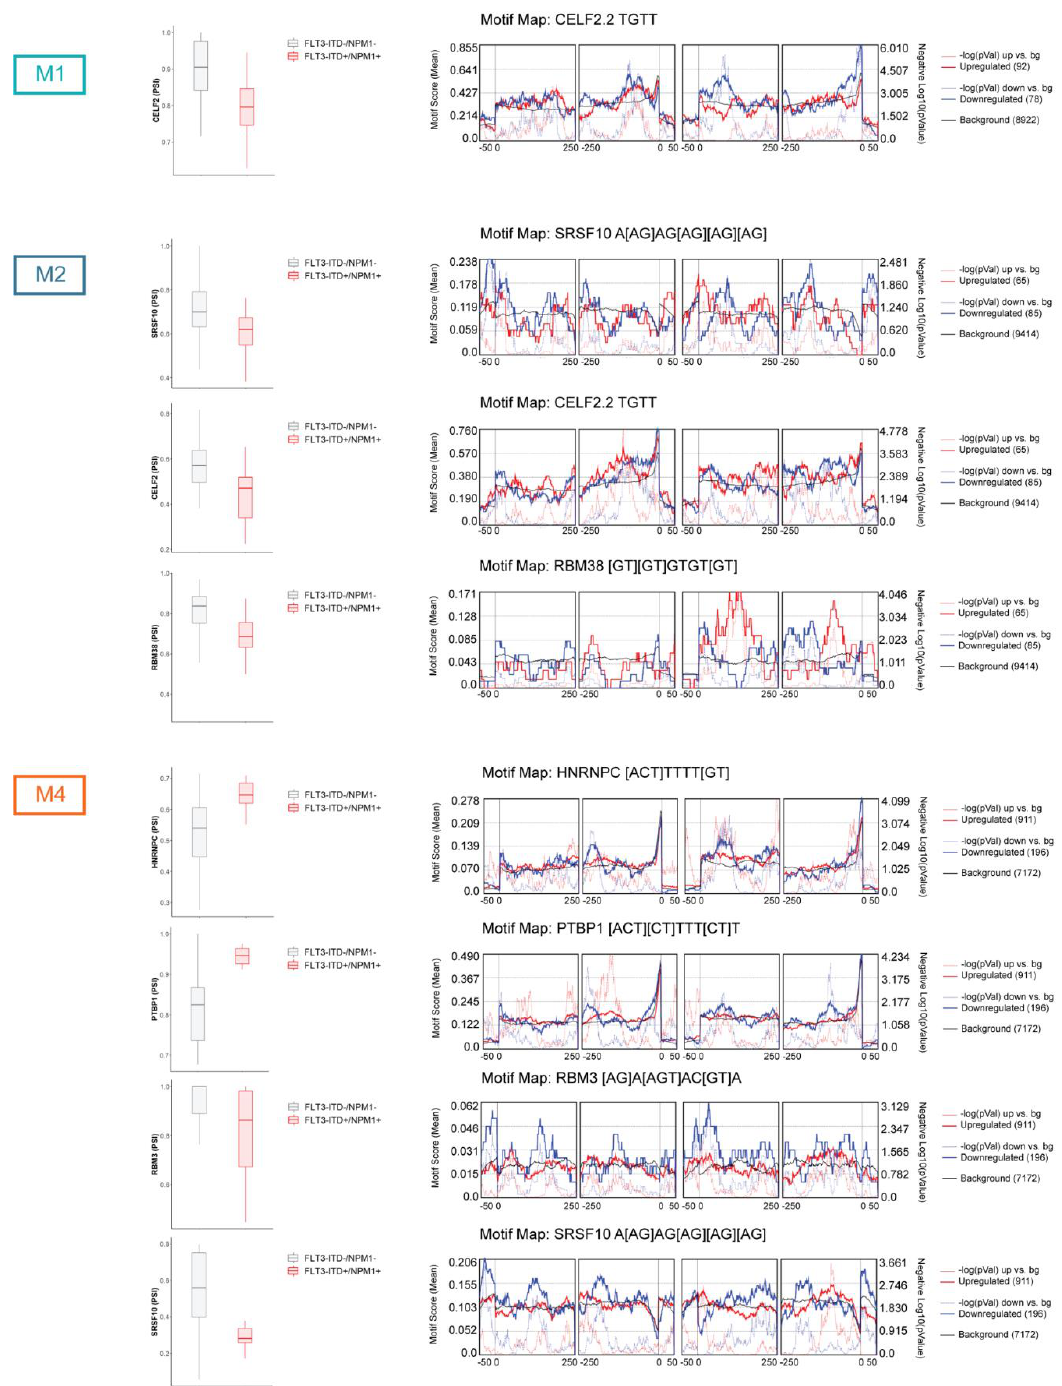
Figure 4. Differential splicing of splicing factors and motif enrichment analysis in relation to FLT3 -ITD and NPM1 mutations. The figure depicts PSI values for selected differentially spliced splicing regulators (FDR < 0.05 and |ΔPSI| > 0.1) in M1, M2 and M4 FAB types as well as motif enrichment analysis for these splicing regulators performed by rMAPS2. This tool evaluates enrichment of motifs recognized by specific splicing factors in significantly differentially spliced events as compared to the background events (all splicing events detected by rMATS, including non-differential events). The motif enrichment is assessed in the differentially spliced exons as well as immediate upstream and downstream sequences. The motif enrichment score (the left y axis) is depicted by the solid blue (for events with ΔPSI < 0) and solid red (for events with ΔPSI > 0) lines. The solid black line indicates motif score for the background events. The negative logarithm of the p -value (right y axis) is depicted by the broken blue (for events with ΔPSI < 0) and red (for events with ΔPSI > 0) lines.